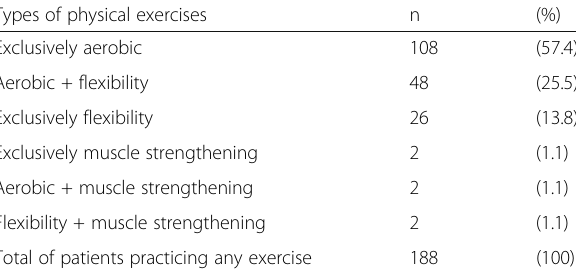
Table 3 Types of physical exercises practiced by patients with fibromyalgia